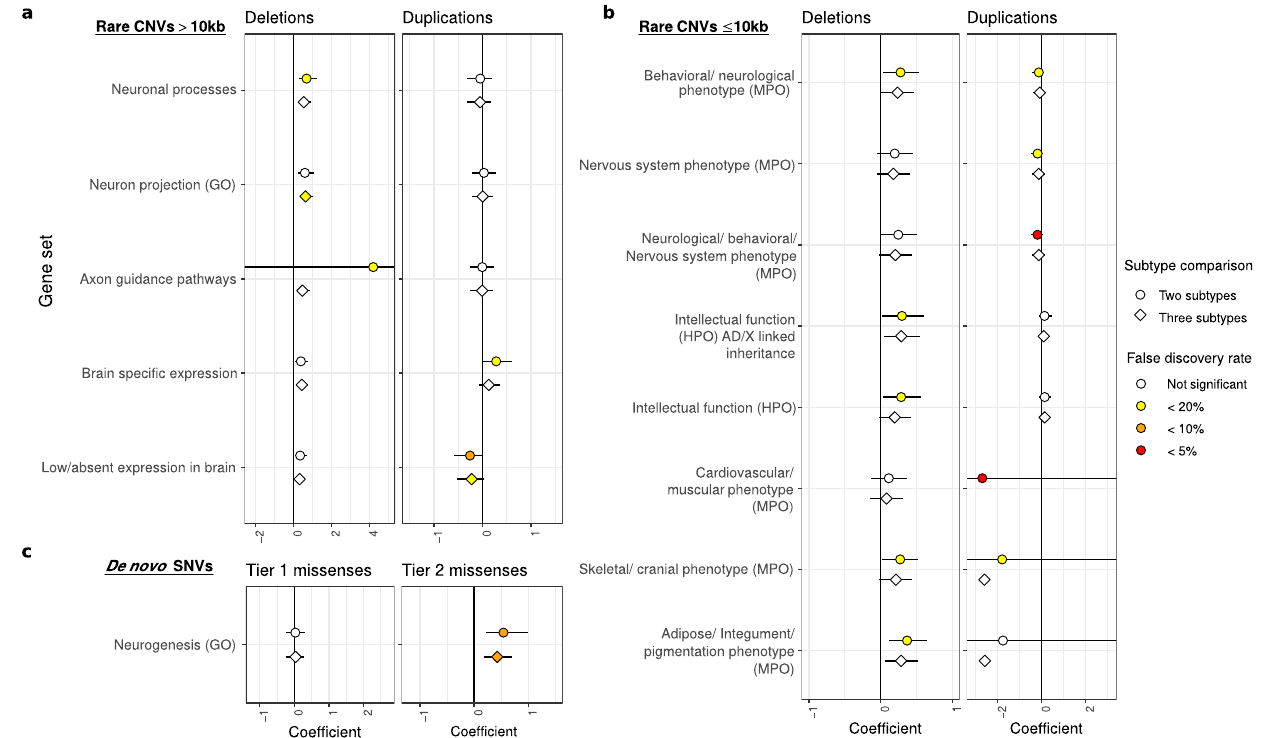
Fig. 2 | Gene sets for which de novo and rare coding variants are signi fi cantly more prevalent in some subtypes of ASD. We de fi ne events as ( a , b ) genes impacted by CNVs or ( c ) as variants for SNVs and indels. The coef fi cient is the relationship betweenthe numberof eventsineachgene setand theASD subtypes; it re fl ects the effect size of a variant type and gene set among different ASD sub- types. Positive coef fi cients indicate more events in individuals with ASD and more ASD and fewer dysmorphic features. We show only gene sets for which ( a , b ) rare CNVs ( n =325 samples), or ( c ) de novo missense variants ( n =235 samples) are signi fi cantly more prevalent in different subtypes of ASD. Tier 1 and 2 missense variants consist of all or only predicted damaging missense variants, respectively,